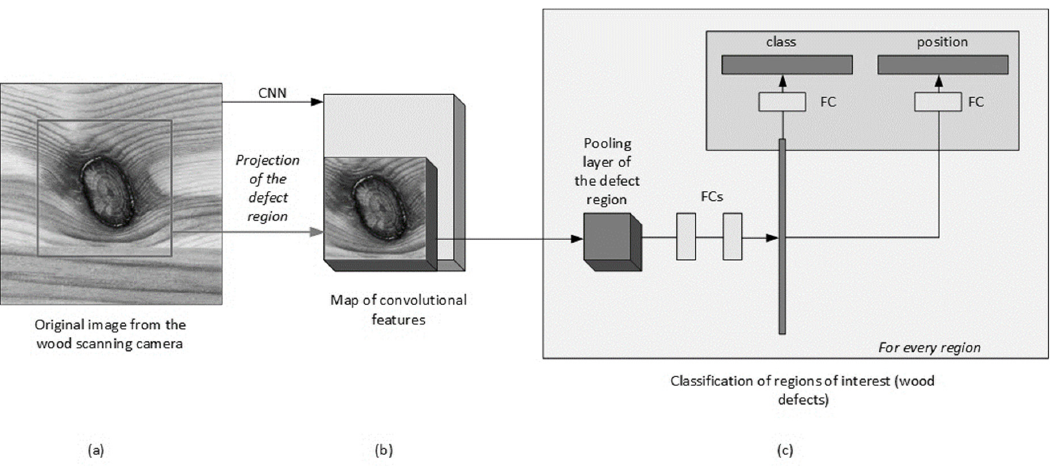
Figure 7. Operation of faster R-CNN: ( a ) original image; ( b ) convolution features; ( c ) classification of regions of interest.